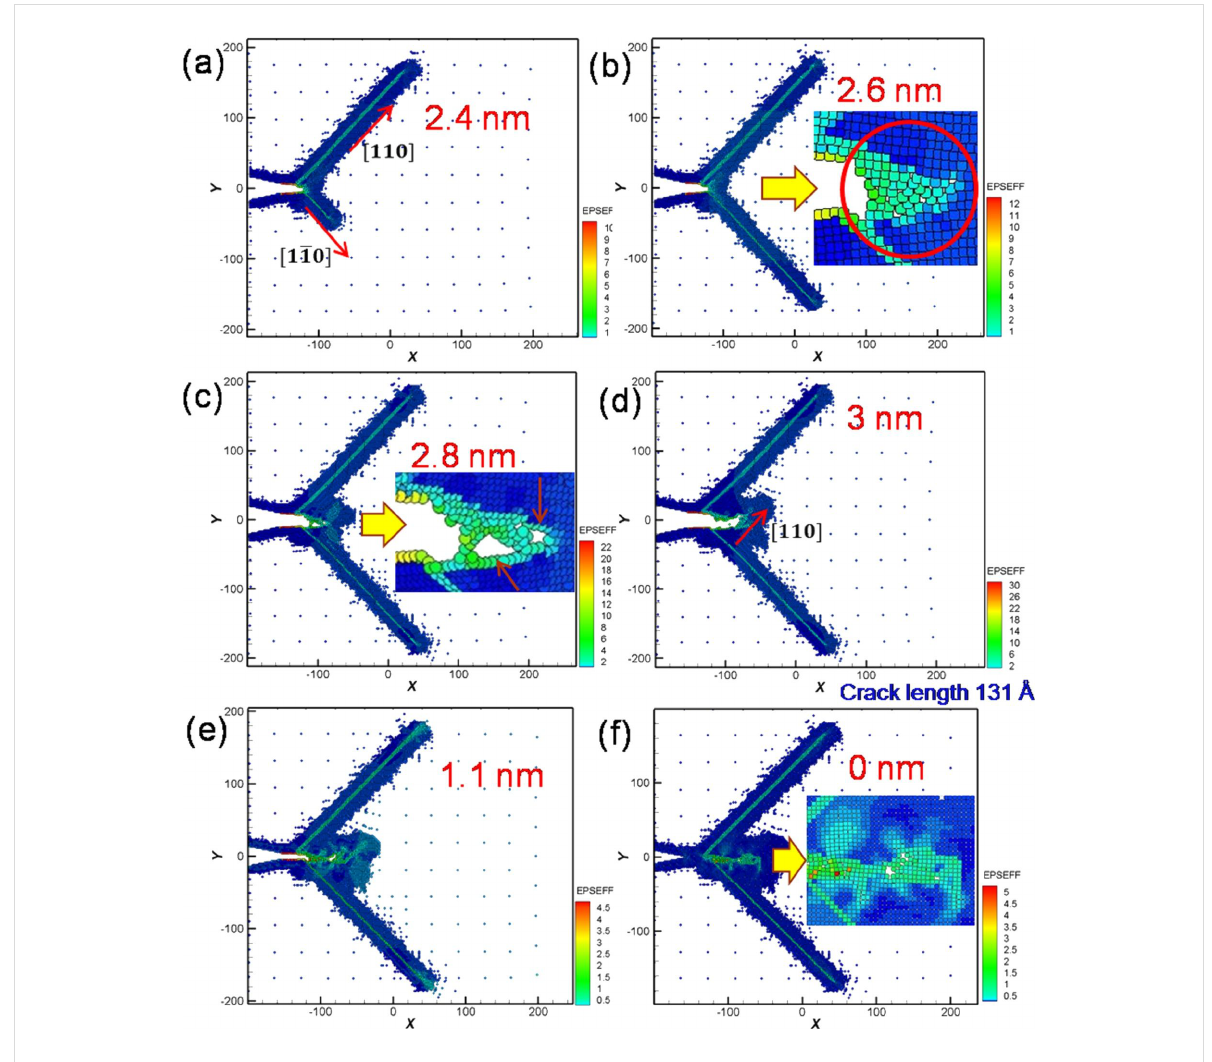
Figure 3: Crack growth and expansion diagrams of Ni under the first cyclic loading at different moving distances. The crack length is 131 Å at a tension distance of 3 nm.